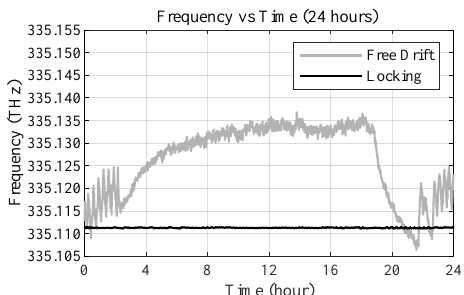
Figure 13. The monitored wavelength data of the VCSEL for 24 h in stable and free drift